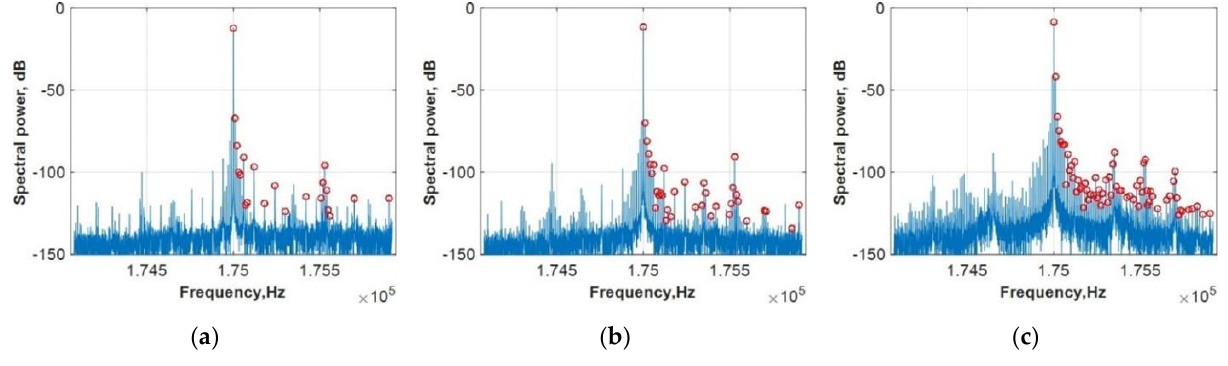
Figure 7. Spectra in the frequency window of 2000 Hz around the probe frequency f = 195 kHz for Sample #5: ( a ) after 0 normalized cycles, no visible crack; ( b ) after 0.69 normalized cycles, initial damage accumulation; ( c ) after 0.9 normalized cycles, visible crack.